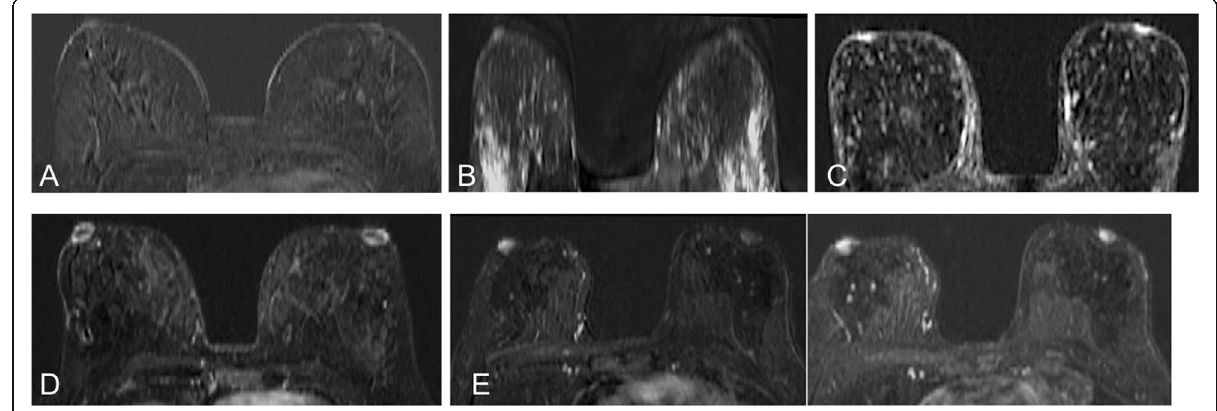
Fig. 12 Physiological enhancement in the nipple-areolar complex. Axial contrast-enhanced T1-weighted spoiled gradient-echo (subtracted) images show various degrees of enhancement in a normal nipple, including none ( a ), mild symmetric enhancement ( b ), intense symmetric enhancement ( c ), a thin symmetric ring of enhancement ( d ), and asymmetric early enhancement with symmetric late enhancement ( e